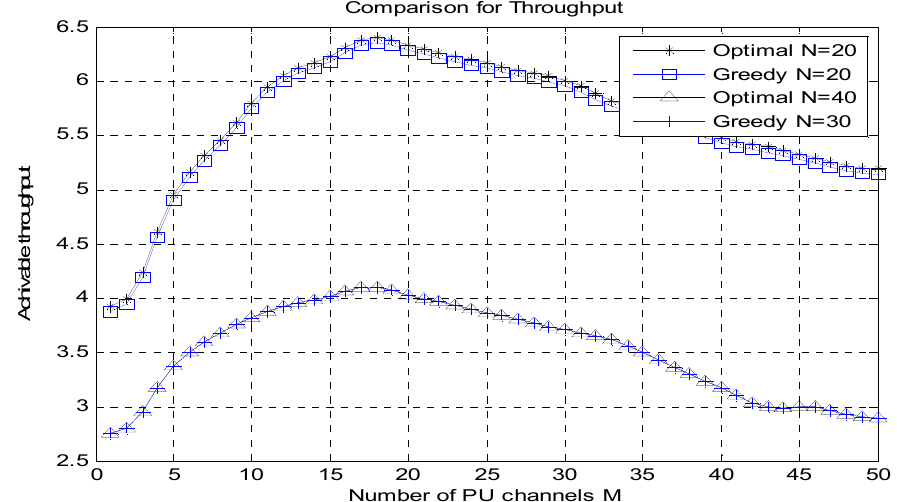
Figure 5. Number of PU channels (M) vs. achievable throughput .